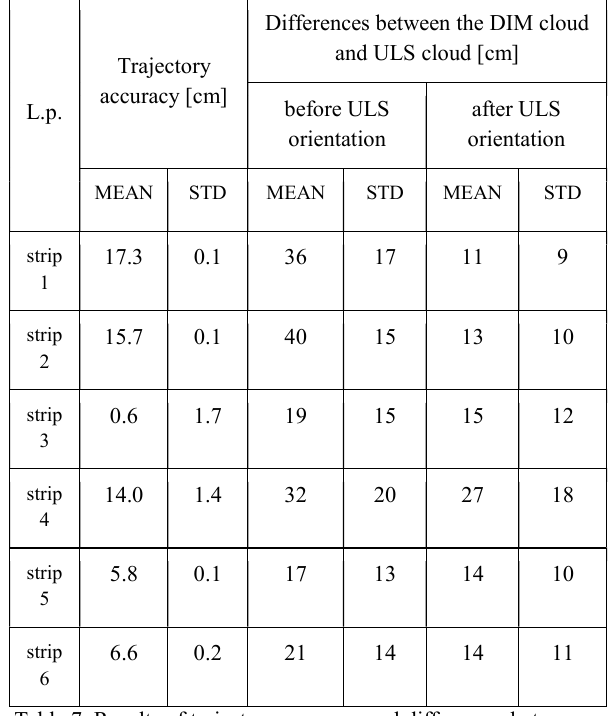
Table 7. Results of trajectory accuracy and differences between photogrammetric and ULS data for individual strips Figure 8 is the presentation of the results in Table 7 with respect to time. The linear and angular errors of trajectory are presented here with the deviations between the ULS and DIM point cloud.